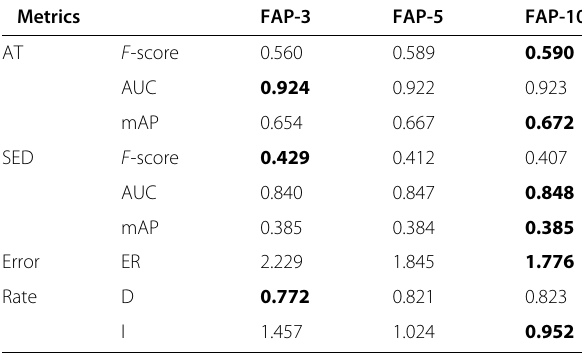
Table 5 The different upper bound setting of FAP Metrics FAP-3 FAP-5